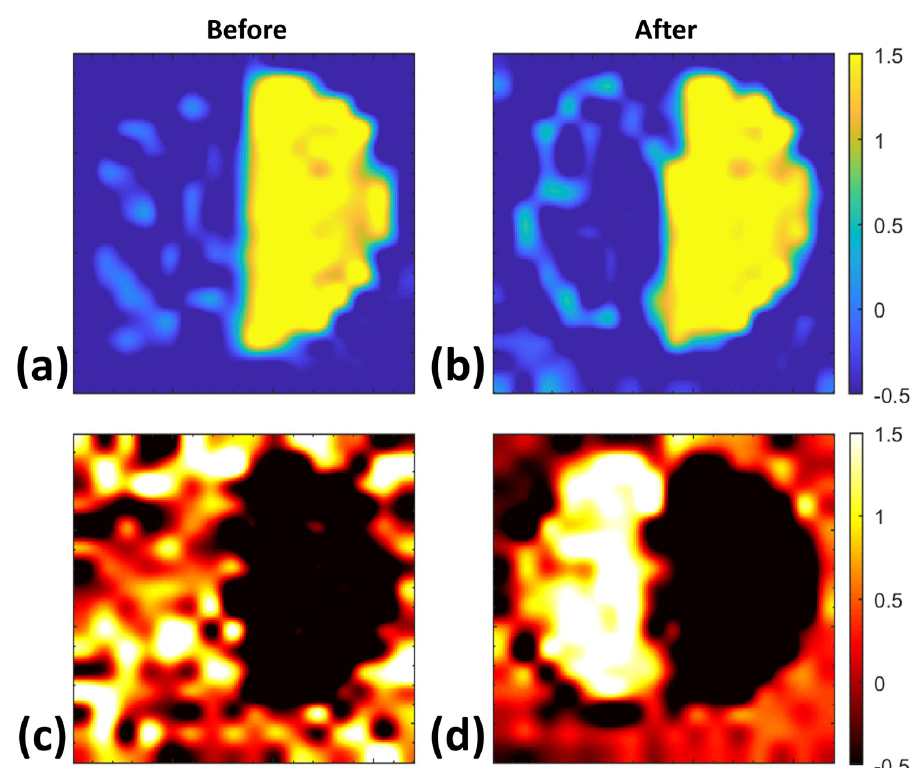
Fig 8. Imaging at θ 0 . The NSS lactose parameter is shown (a) before and (b) after cepstrum filtering. The NSS riboflavin parameter is shown (c) before and (d) after cepstrum